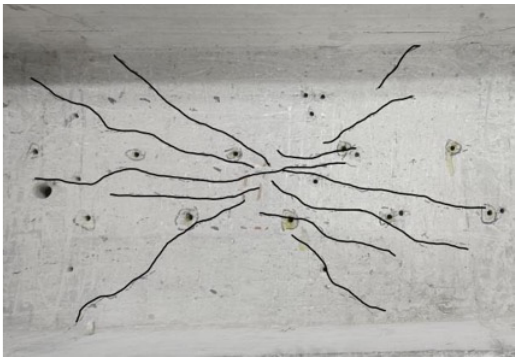
Figure 9. The fatigue damage mode of P3 after 500,000 fatigue cycles.